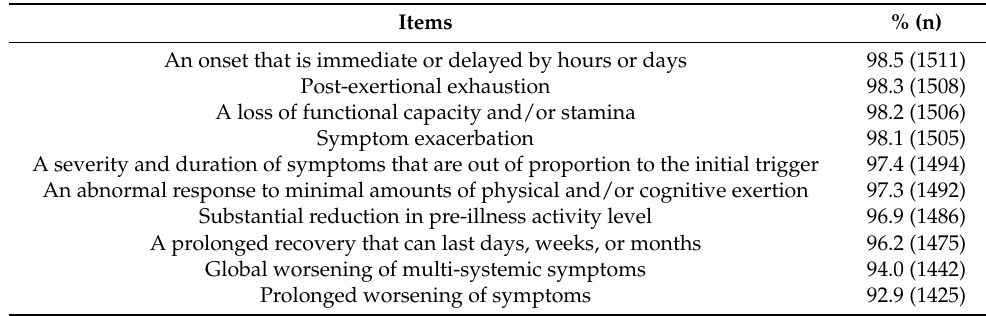
Table 5. If you go beyond your energy limits by engaging in pre-illness tolerated exercise or activities of daily living, do you experience any of the following? ( N = 1534).